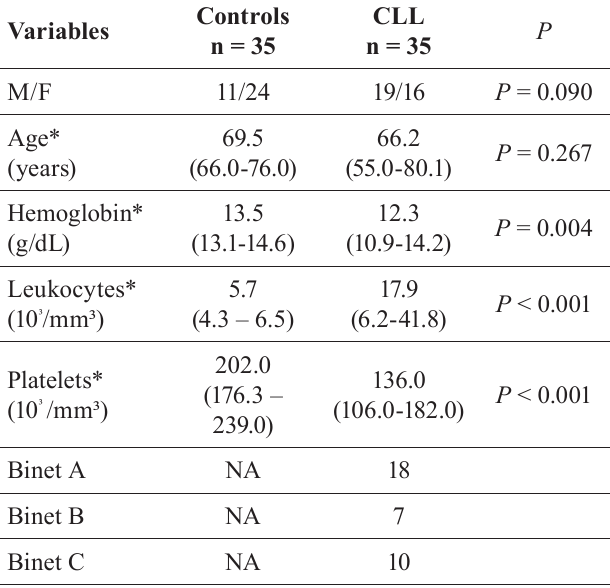
TABLE I - V ariables in patients with CLL and in matched healthy control individuals